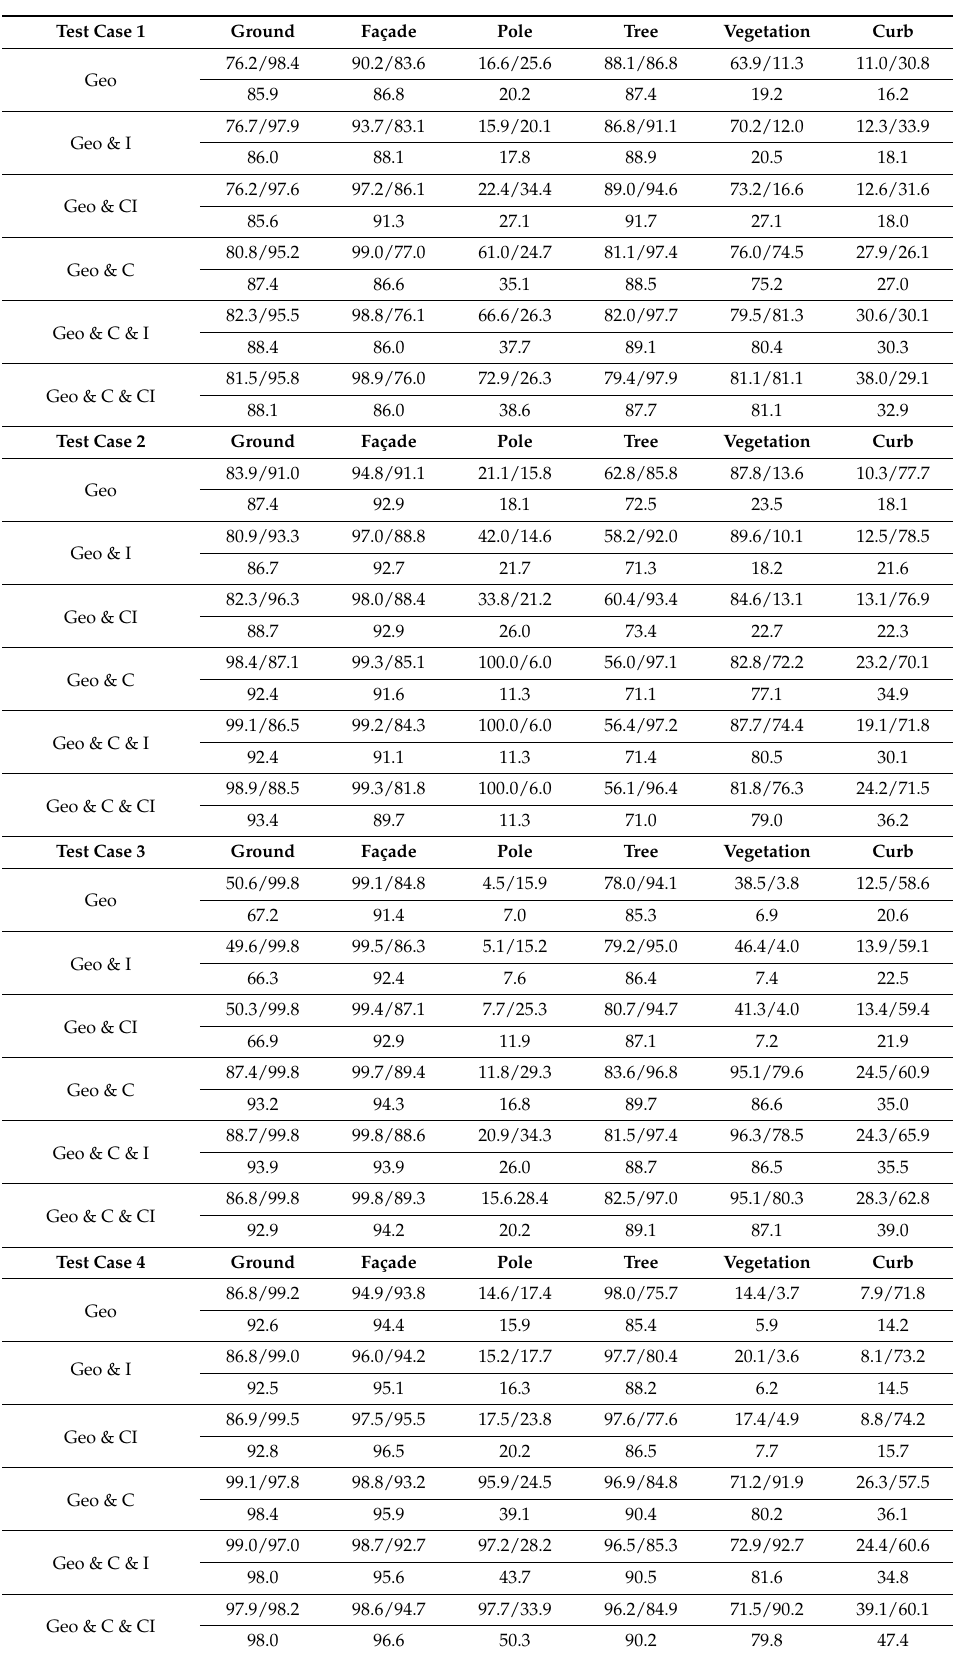
Table 4. Precision/Recall and F1 score values (in %) of four testing sets for different feature